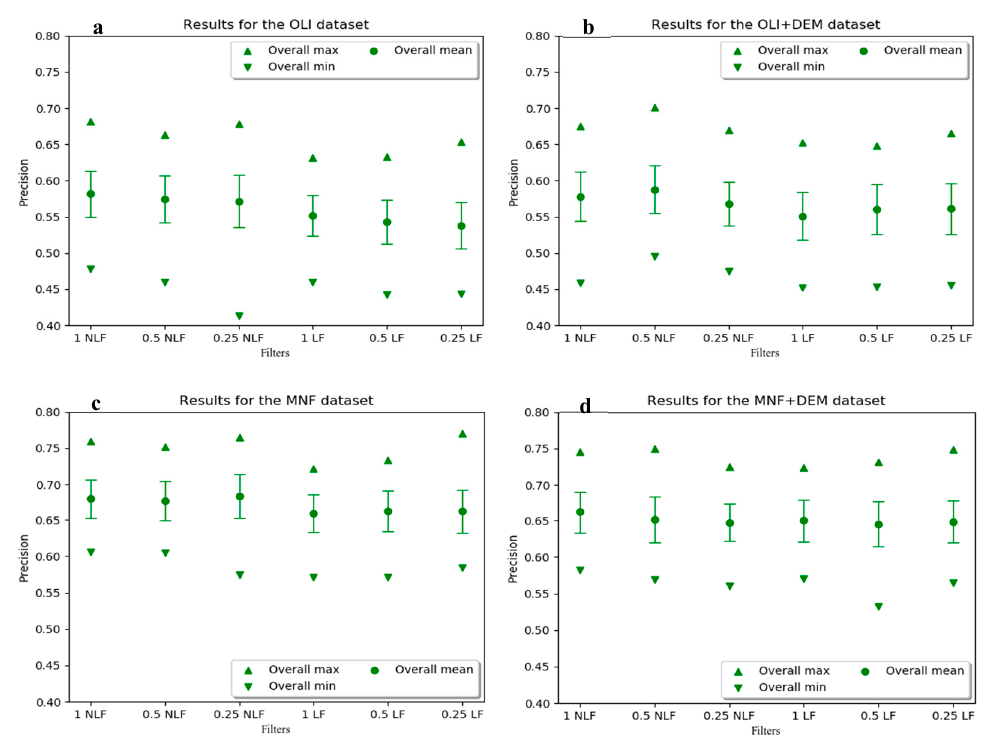
Figure 8. Precisions obtained for each input dataset using six different filter configurations. “Overall max” is the highest Precision obtained. “Overall mean” is the mean precision obtained with its standard deviation. “Overall min” is the lowest precision obtained. NLF: no lithological filter, LF: lithological filter, 1: no data threshold 100%, 0.5: no data threshold 50%, 0.25: no data threshold 25%. ( a ) Precisions obtained on the OLI dataset only. ( b ) Precisions obtained when the OLI dataset is stacked with a DEM. ( c ) Precisions obtained on the OLI dataset after using an MNF transform. ( d ) Precisions obtained on the OLI dataset stacked with a DEM after performing an MNF transform.